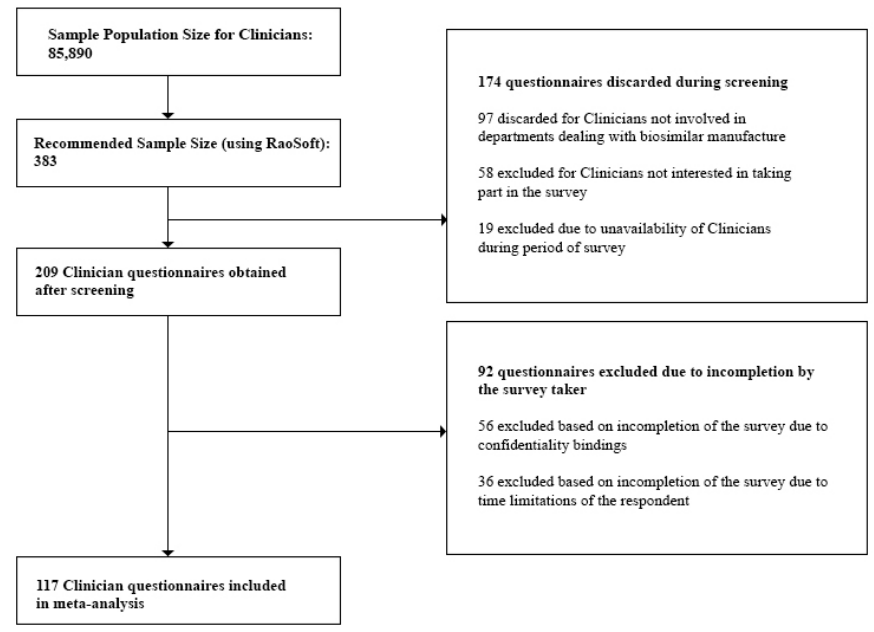
Figure 1. Questionnaire screening process for Clinicians. Biomolecules 2018 , 8 , x FOR PEER REVIEW